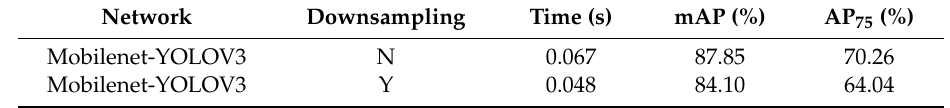
Table 4. Results of the framework based on Mobilenet-YOLOV3 with and without downsampling.